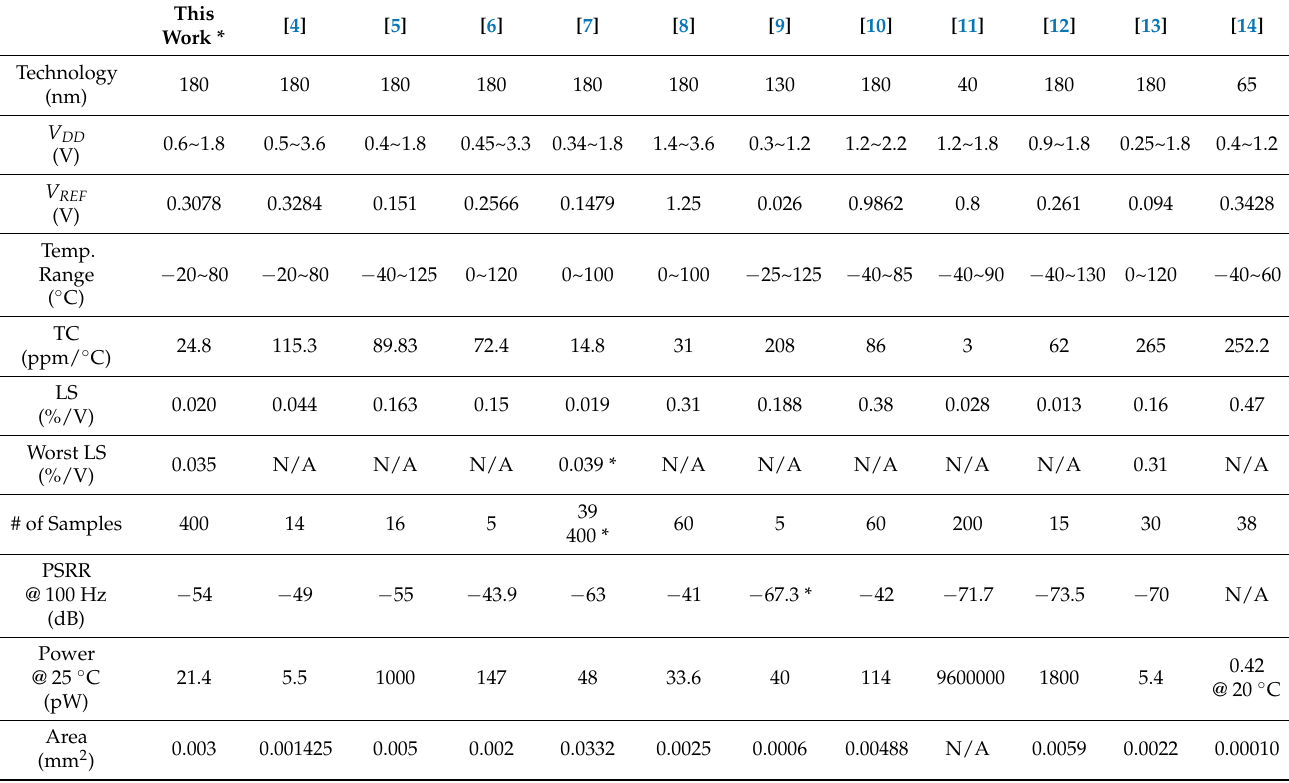
Figure 14. Simulated PSRR at 25 ◦ C and V DD = 0.6 V. Table 2. Performance summary and comparison to other